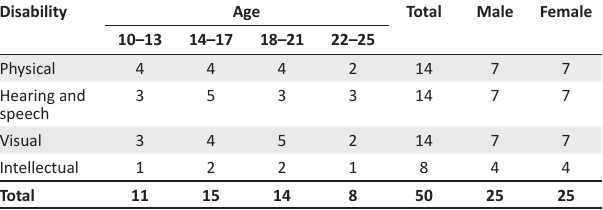
TABLE 1: Characteristics of children and young adults with disabilities interviewed.